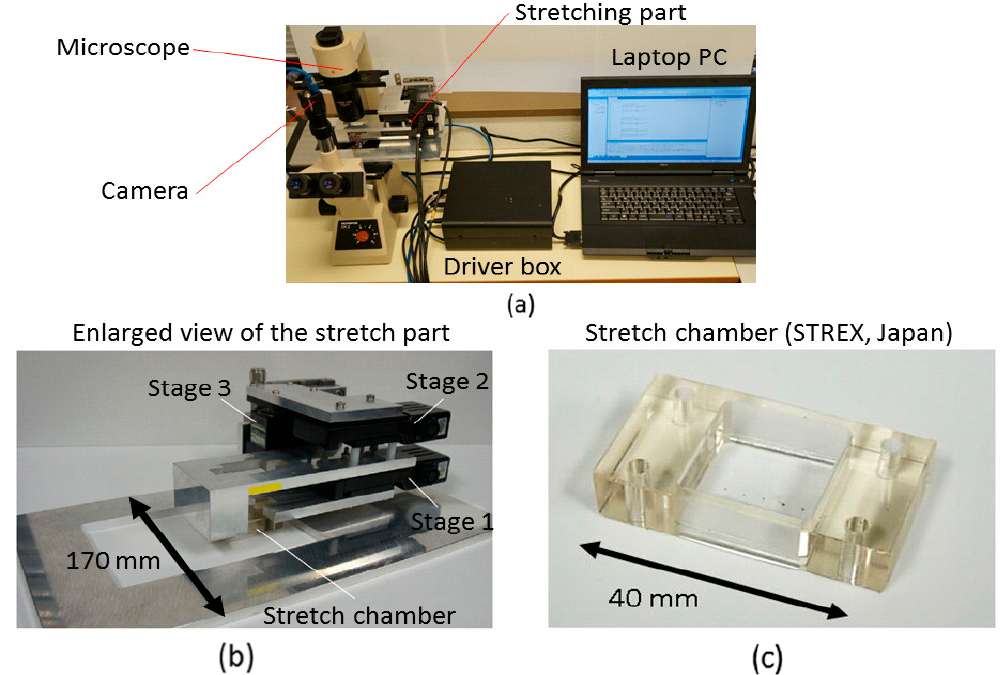
Figure 3. Overview of the developed system with the stages. ( a ) System setup. ( b ) Stage unit. ( c ) A stretch chamber with a thin membrane (approximate 200 µ m) for on-line cell observation.